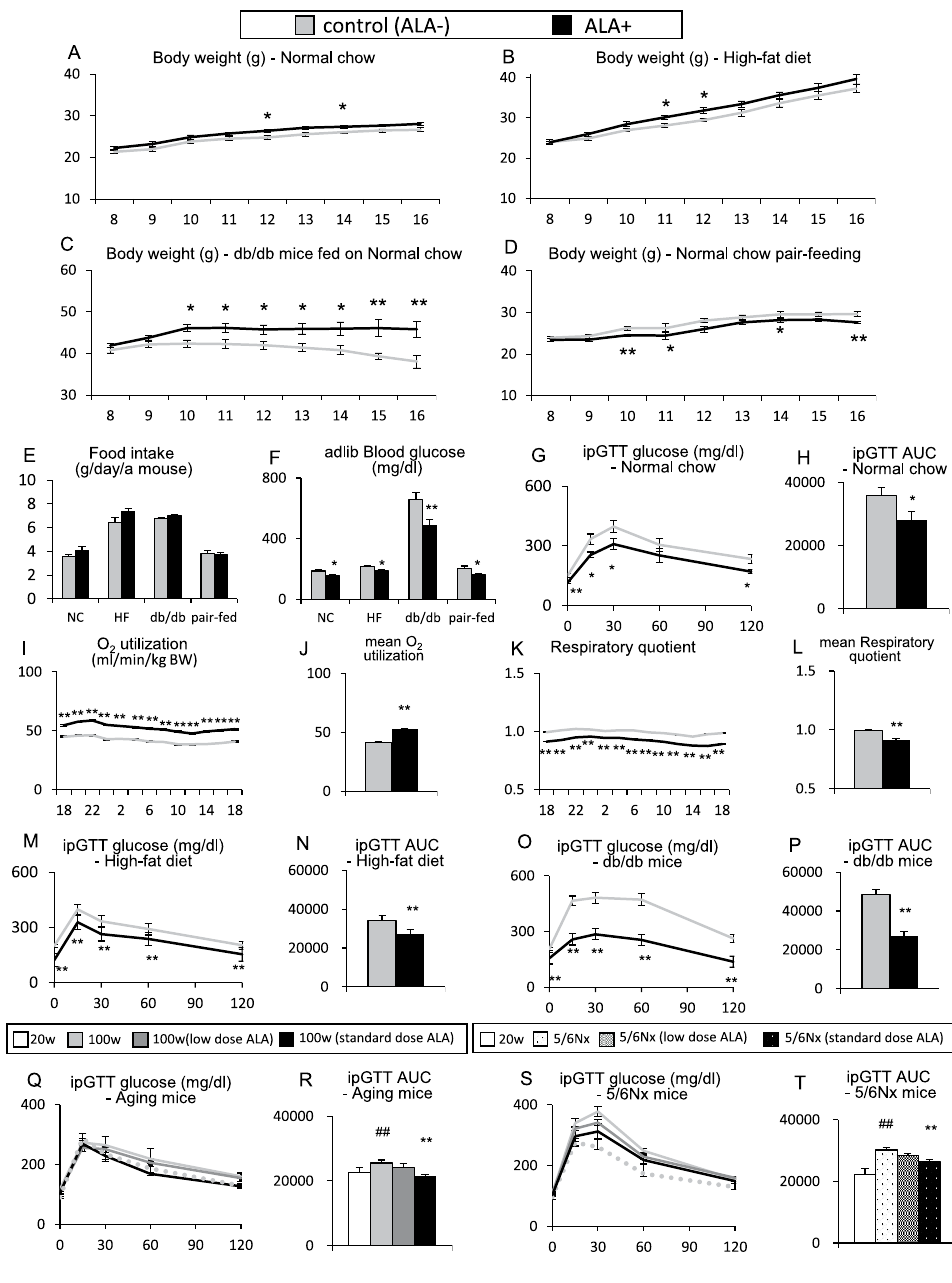
Figure 5. 5-aminolevulinic acid improves glucose tolerance without reducing body weight. ( A – D ) Body weight ( A ) normal chow at 8–16 weeks (8–16); N = 10 in each group, ( B ) High-fat diet; N = 10 in each group, ( C ) db/ db obese mice on normal chow; N = 5 in each group, ( D ) Normal chow pair-fed mice; N = 10 in each group), ( E ) Food intake (average daily intake per mouse), ( F ) Adlib blood glucose at 16 weeks of age (16 W), ( G ) ipGTT in ALA-treated mice with normal chow, ( H ) Area under the curve (AUC) of ipGTT, ( I ) Oxygen utilization of ALA-treated mice with normal chow (16 W); N = 6 in each group, ( J ) Mean oxygen utilization, ( K ) Respiratory quotient of ALA-treated mice with normal chow (16 W); N = 6 in each group, ( L ) Mean respiratory quotient, ( M ) ipGTT in ALA-treated mice with high-fat diet; N = 5 in each group, ( N ) ipGTT AUC (high-fat diet), ( O ) ipGTT in ALA-treated db/db obese mice; N = 5 in each group, ( P ) ipGTT AUC (db/db mice), ( Q ) ipGTT in ALA-treated mice with normal chow 20-week-old mice (20 W), control 100-week-old mice (100 W), low dose ALA-treated aged mice, standard dose ALA-treated aged mice; N = 8 in each group, ( R ) ipGTT AUC (aged mice), ( S ) ipGTT in ALA-treated mice with normal chow; 20-week-old mice (20 W), control 5/6Nx mice, low dose ALA-treated 5/6Nx mice, standard dose ALA-treated 5/6Nx mice, ( T ) ipGTT AUC (5/6Nx mice); N = 8 in each group. * P < 0.05, ** P < 0.01 versus aged mice without ALA-treatment or 5/6Nx mice without ALA treatment group. # P < 0.05, ## P < 0.01 versus the control group. ALA, 5-aminolevulinic acid; ipGTT, intra- peritoneal glucose tolerance test; AUC, area under the curve; 5/6Nx, 5/6